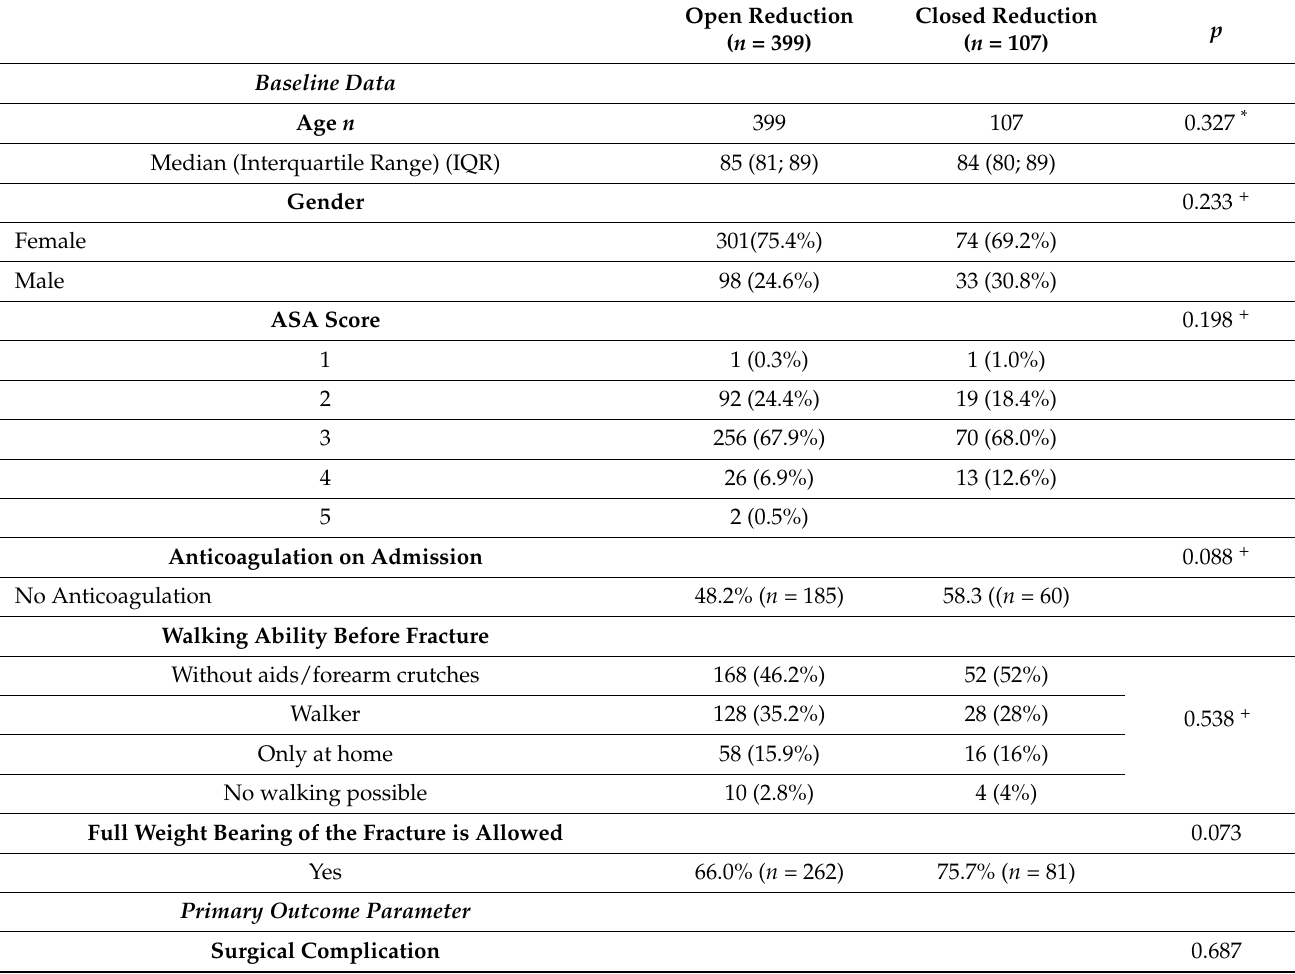
Figure 1. The rate of complications after open vs. closed reduction. Table 2. Open vs. closed reduction (initial